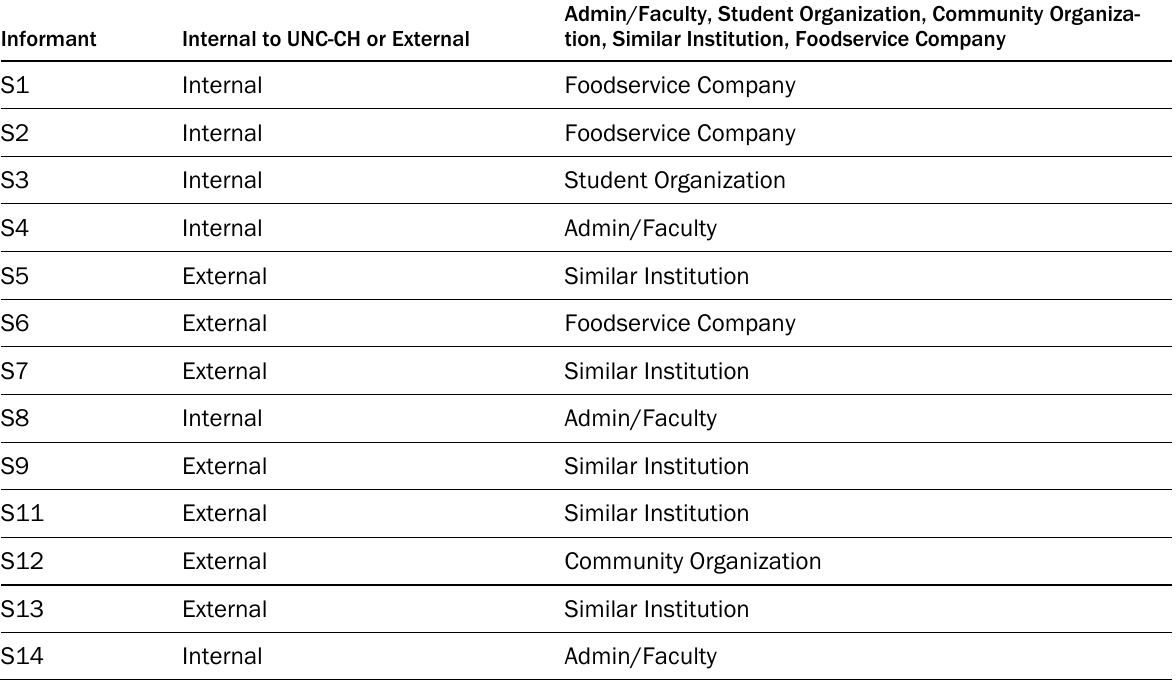
Table A1. Interviews by Interviewee Type